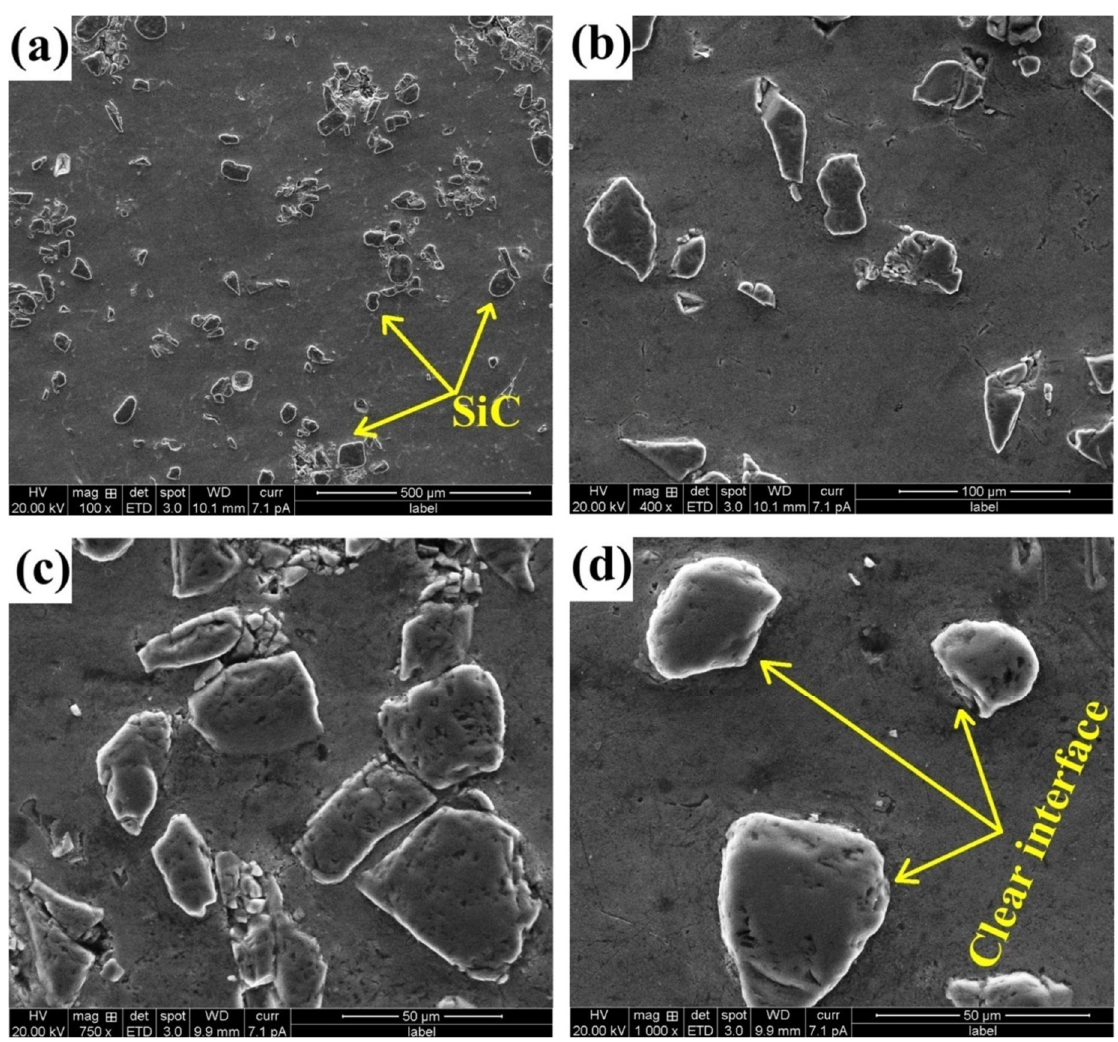
Figure 3. SEM images of AA 6061-15 vol.% SiC at magnification ( a ) 100X; ( b ) 400X; ( c ) 750X; ( d ) 1000X